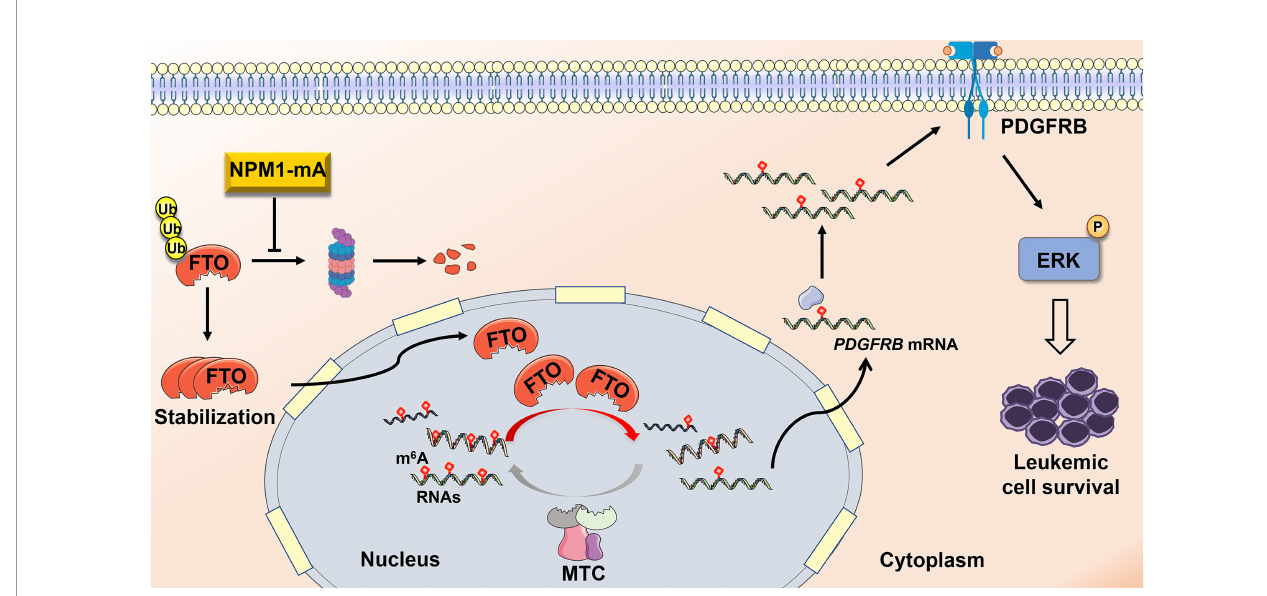
FIGURE 6 | Schematic diagram illustrating the functional signi fi cance of FTO-mediated m 6 A demethylation in NPM1-mutated leukemic cells. NPM1-mA stabilizes the FTO protein to reduce the global m 6 A abundance, leading to activation of PDGFRB/ERK signaling axis and further promoting leukemic cell